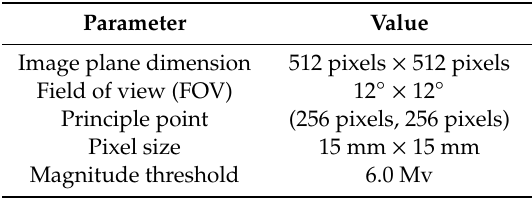
Table 1. The star sensor configuration.